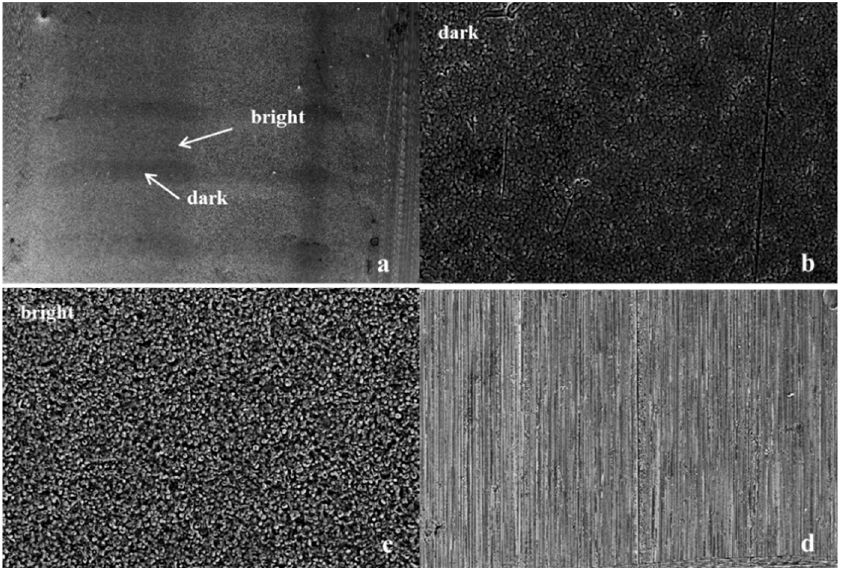
Figure 5. Bearing corrugated damage and its microstructure (a) Corrugated damage of raceway surface (b) Micro-morphology of dark area (c) Micro-morphology of bright area (d) No damage area.